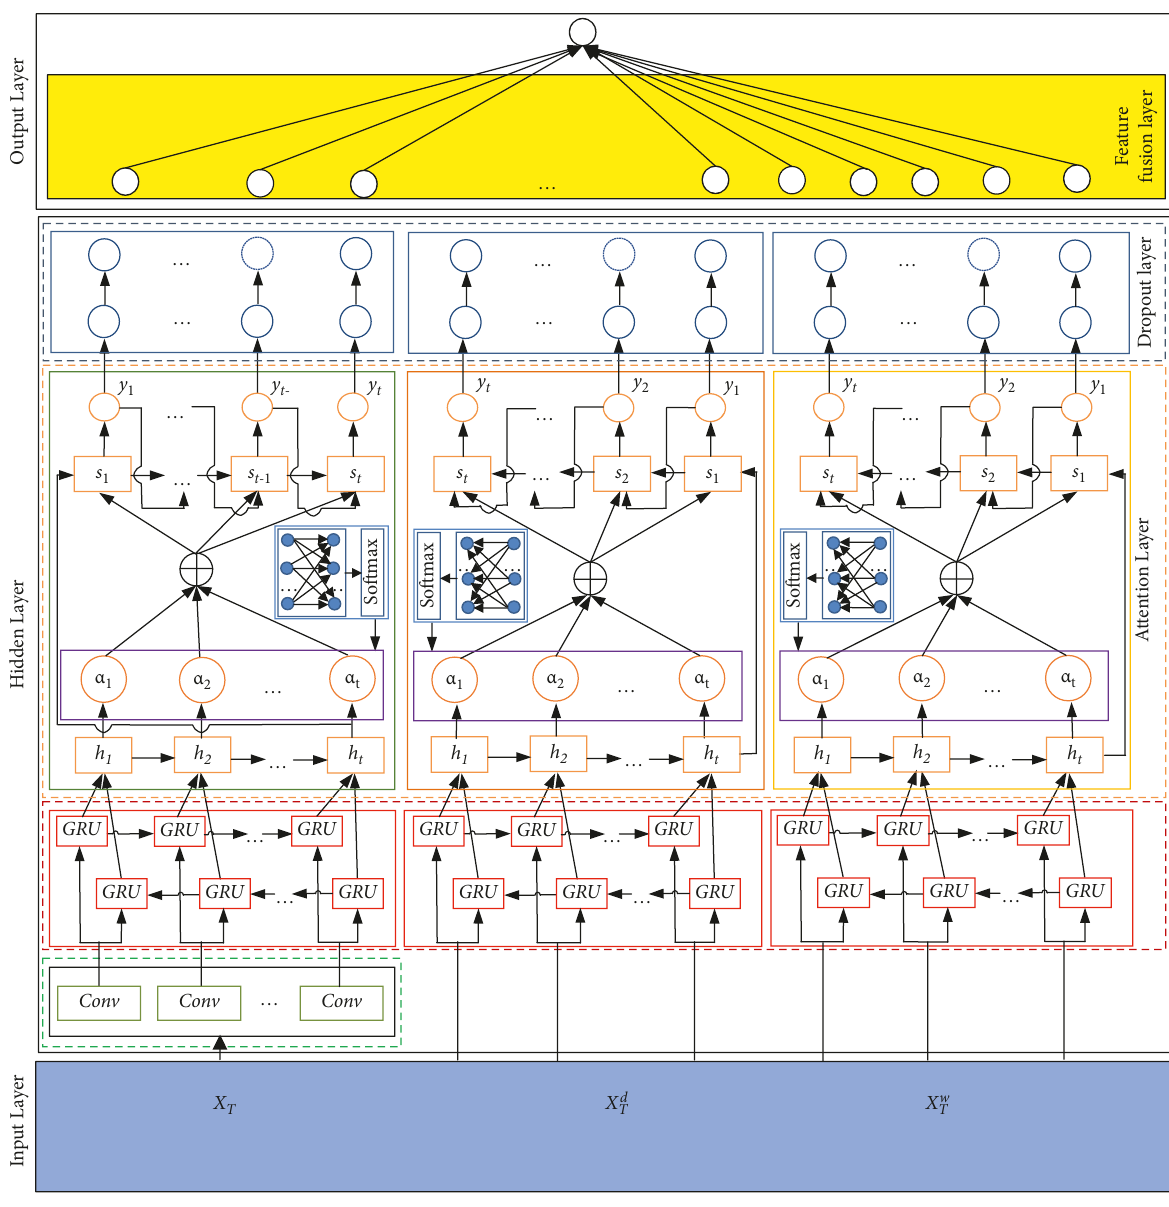
Figure 3: Structure of the multi-feature fusion